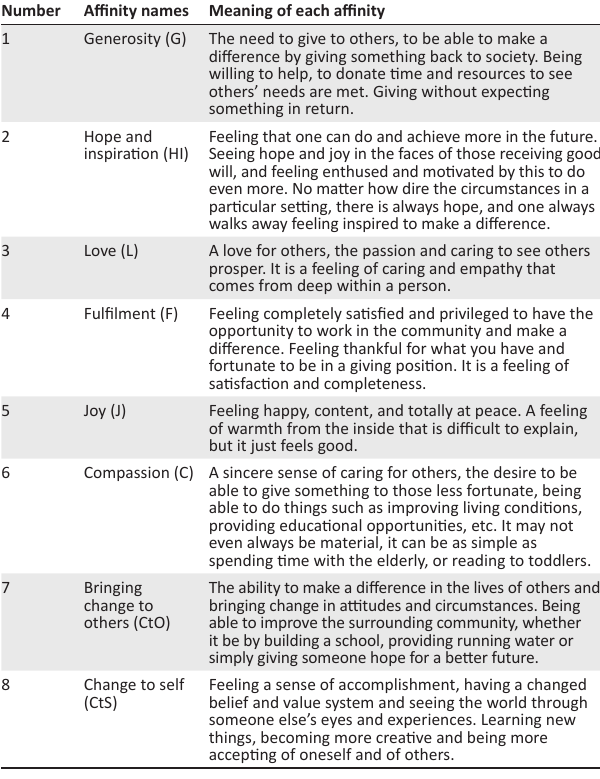
TABLE 2: Affinities generated by the focus group. Number Affinity names Meaning of each affinity